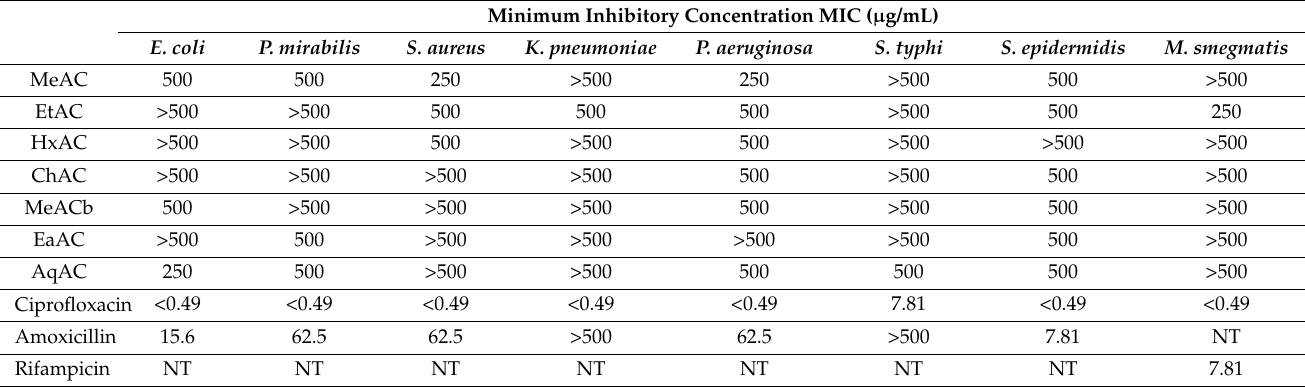
Table 2. Effect of extracts of Allium cepa on the growth of